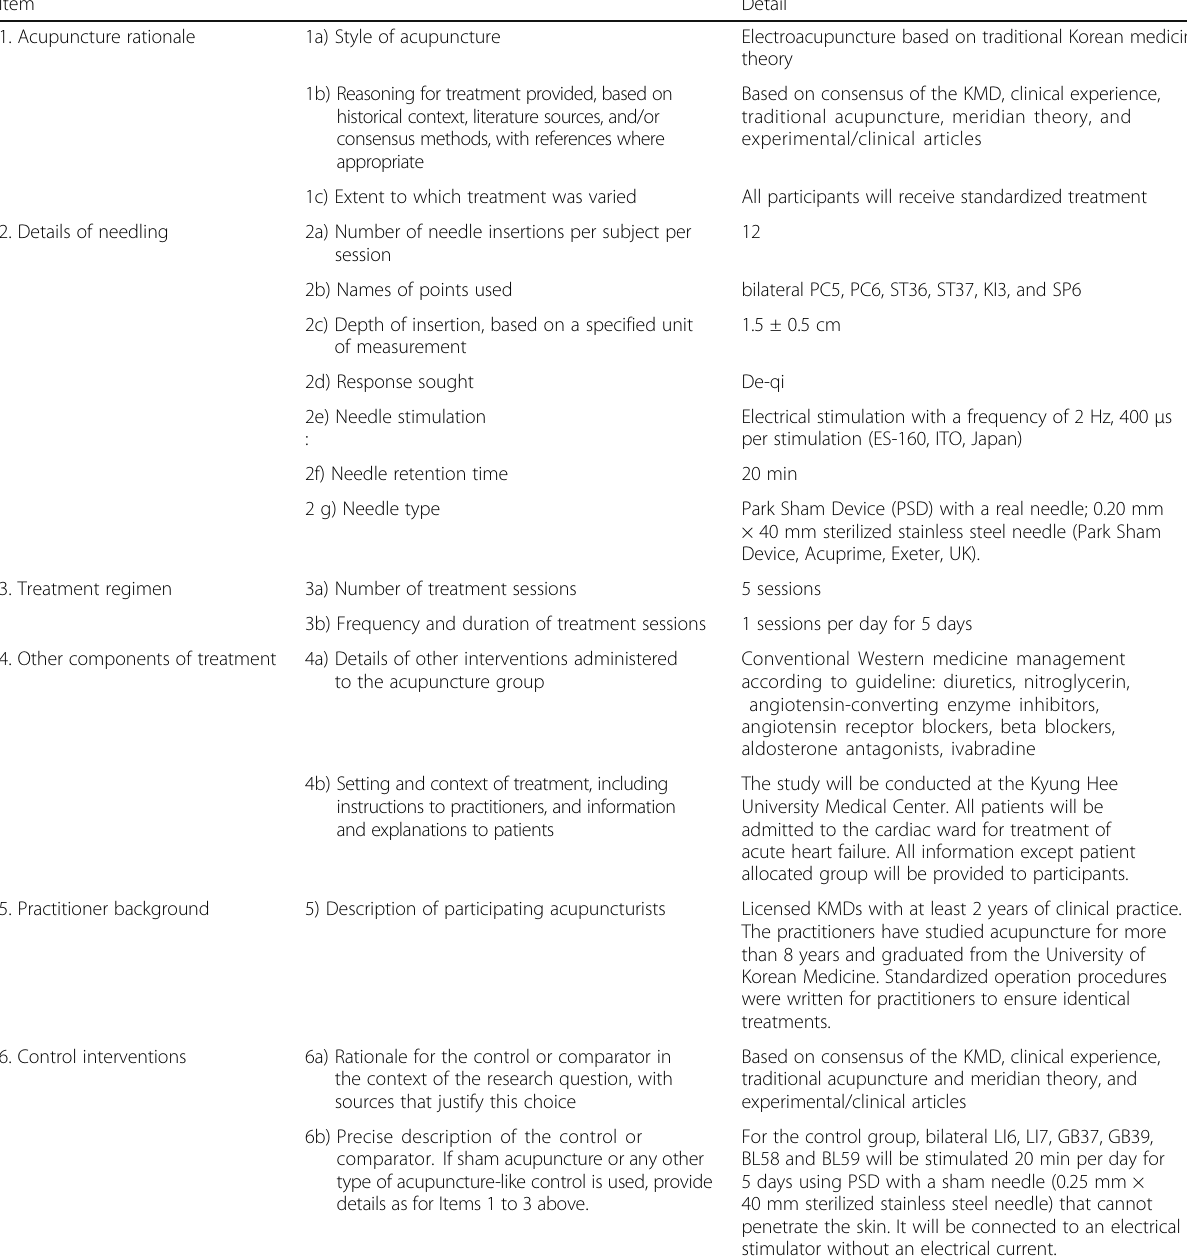
Table 2 Details of acupuncture treatments based on the STRICTA 2010 checklist